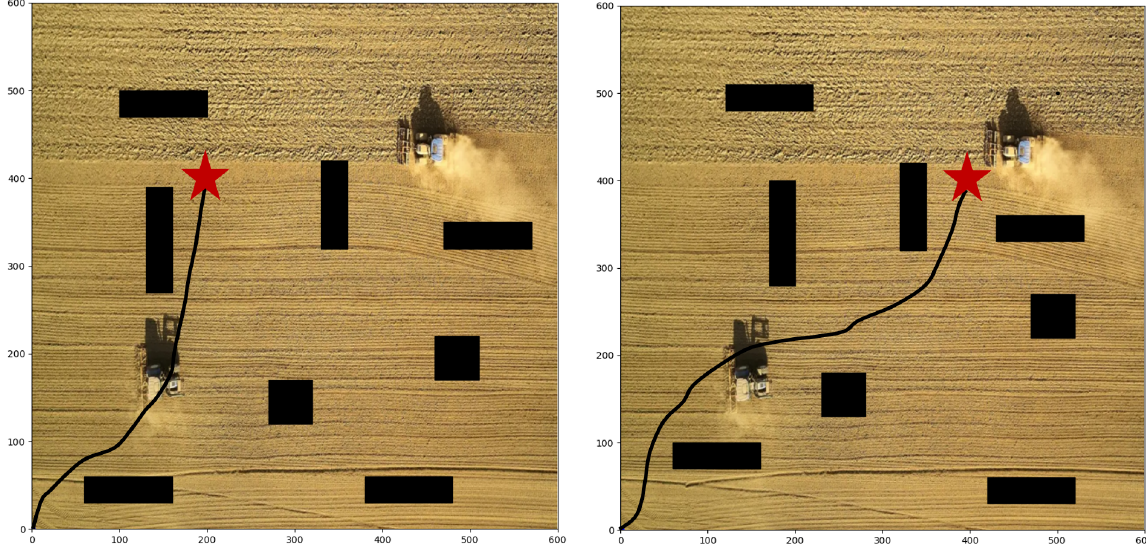
Figure 11. The planned paths with target point of (200, 400) and (400, 400) and dynamic